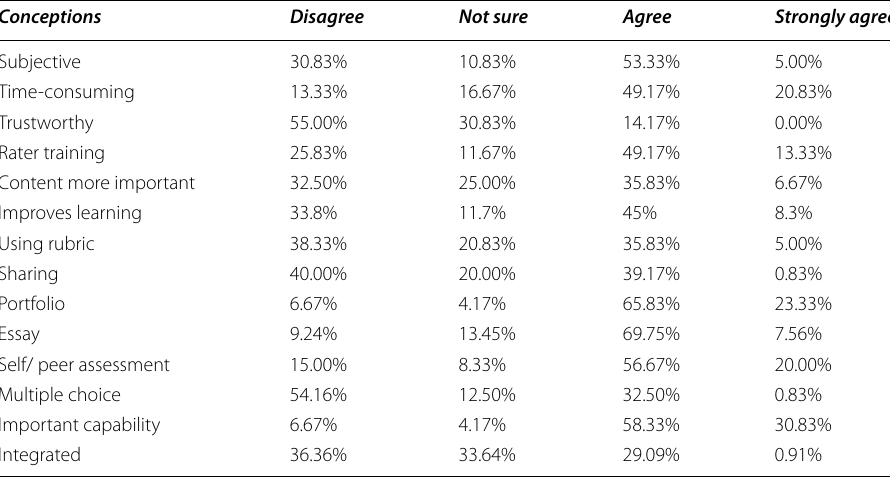
Table 3 Teachers’ conception of writing assessment